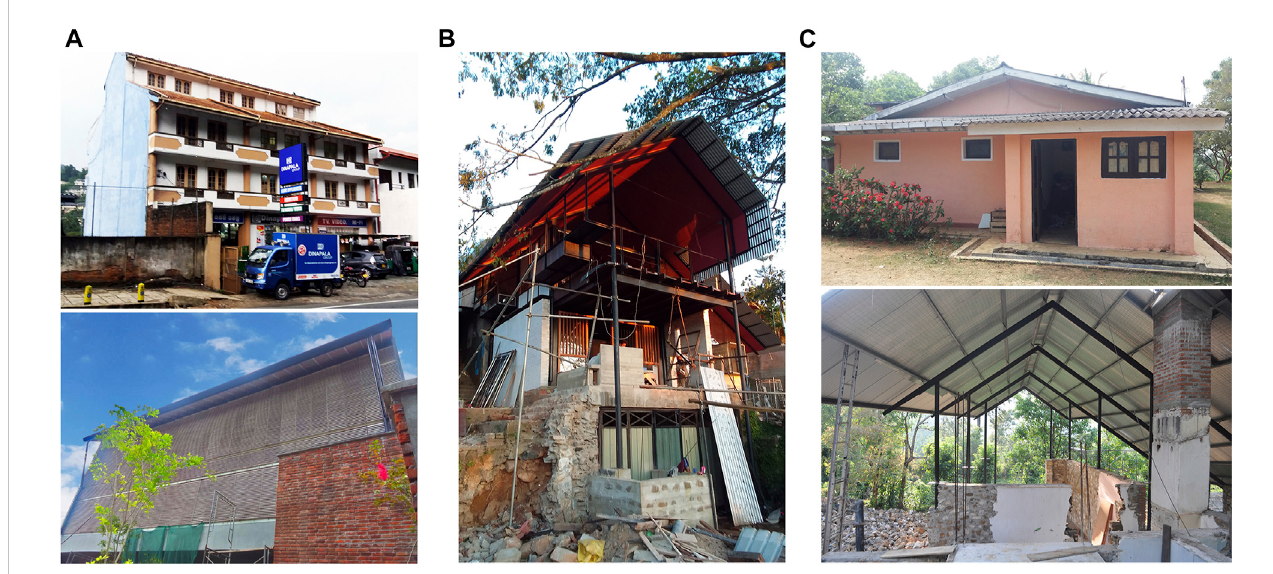
FIGURE 8 City project: section showing the two facade screens “ wrapping ” the fabric to form the habitable loggias.